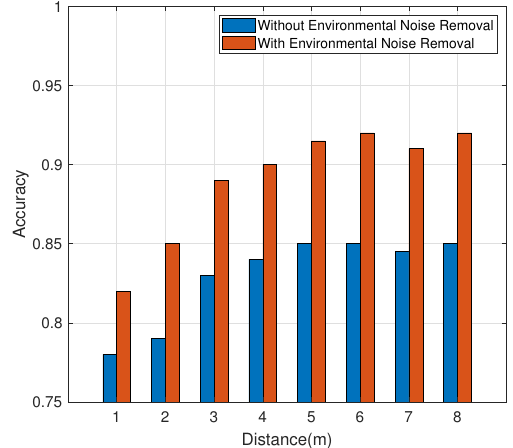
Figure 13. Impact of environmental interference.